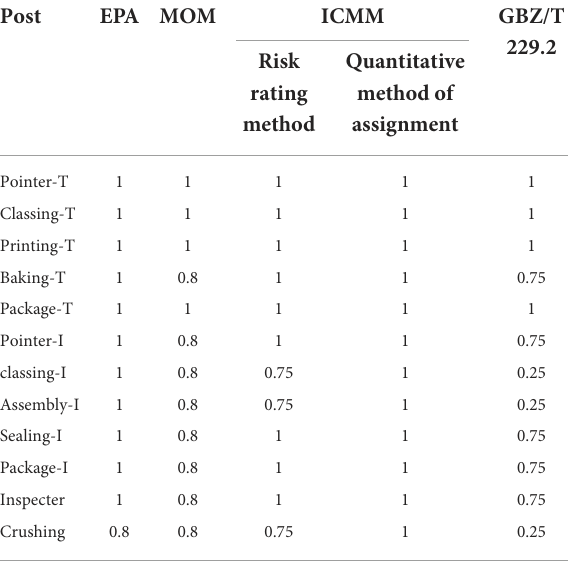
TABLE 8 Results of Spearman correlation